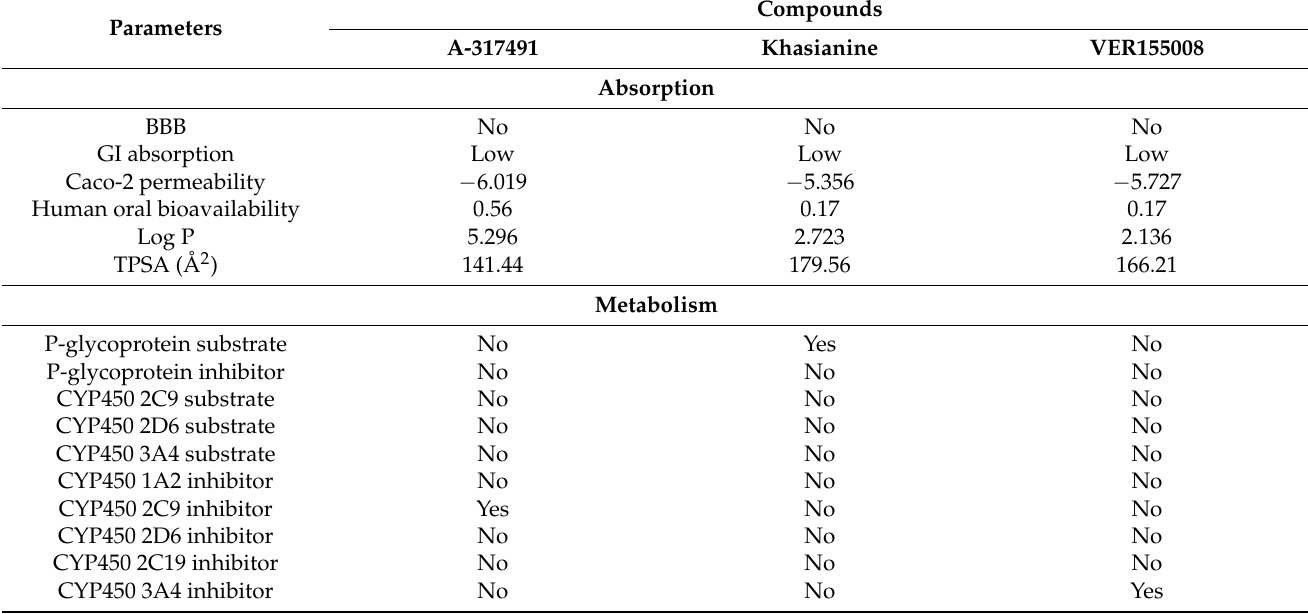
Table 2. Predicted ADME and Toxicity properties of identified nucleoside analogs. The probability of each parameter is depicted. BBB : blood–brain barrier; CYP450 : cytochrome